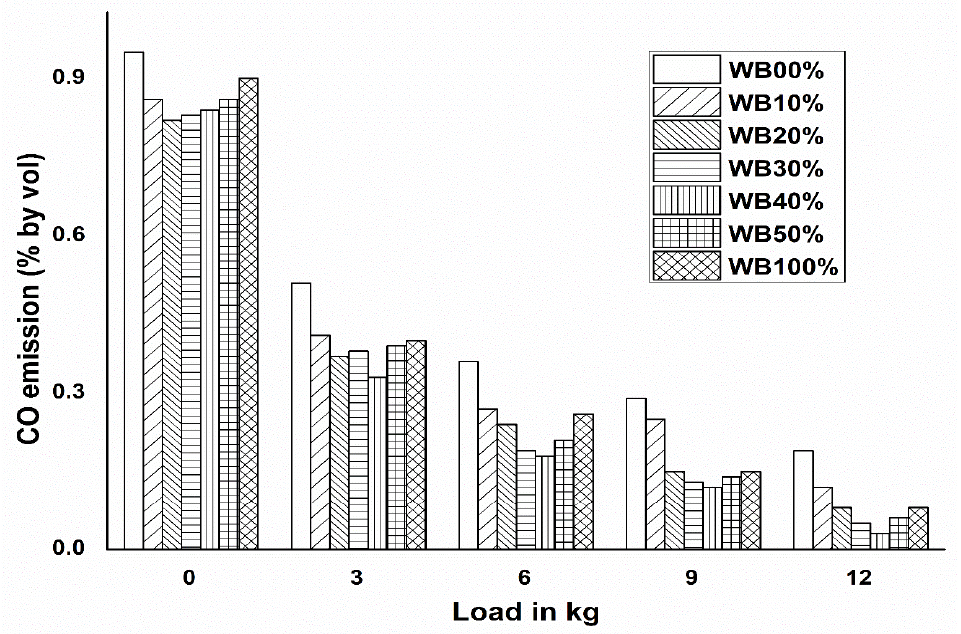
Figure 7. CO emissions’ variation against load for biodiesel and the blends (kg).